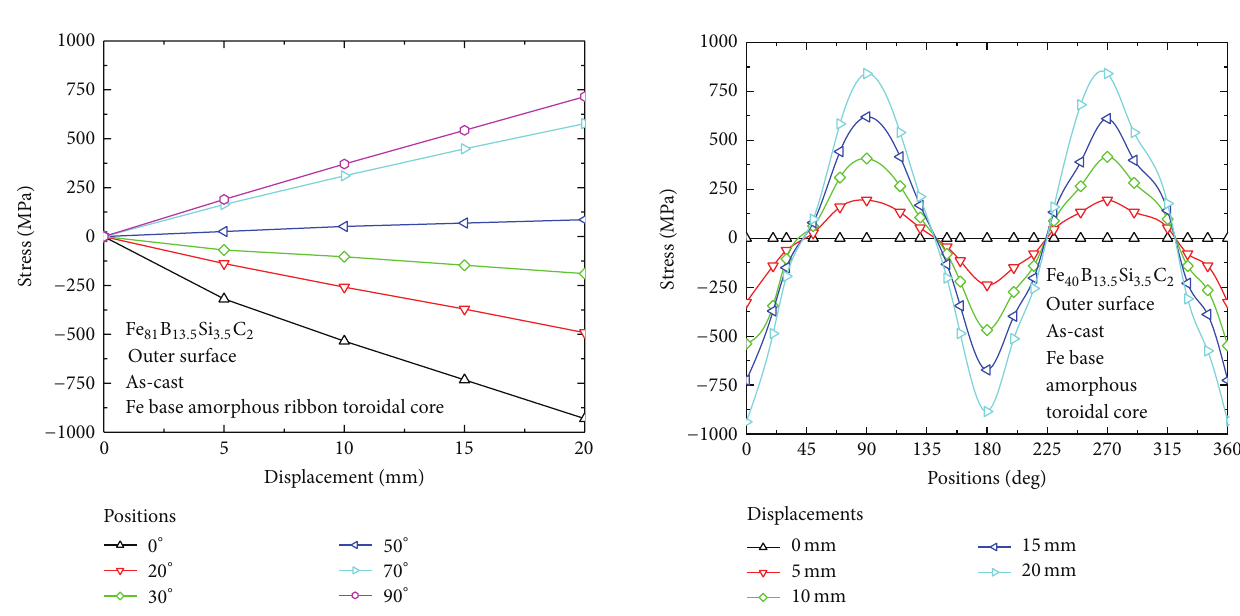
Figure 9: Stress distribution on the outer surface of the as-cast, Fe based, 0.5 mm thick, and 30 mm inner diameter amorphous toroidal transducer core for 0 ∘ , 20 ∘ , 30 ∘ , 50 ∘ , 70 ∘ , and 90 ∘ positions.